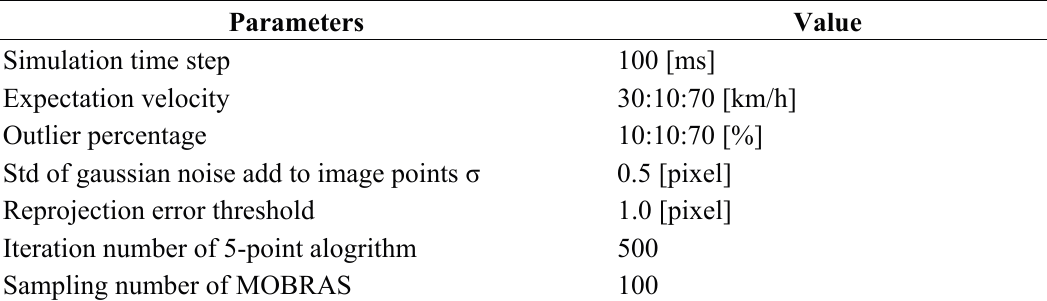
Table 1. Simulation parameters.